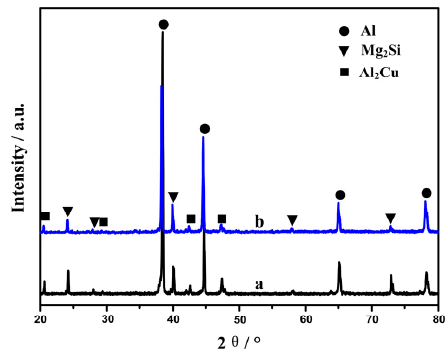
Figure 1. X ‐ ray diffraction (XRD) results for as ‐ cast alloys: ( a ) Al–18Mg 2 Si–4.5Cu;